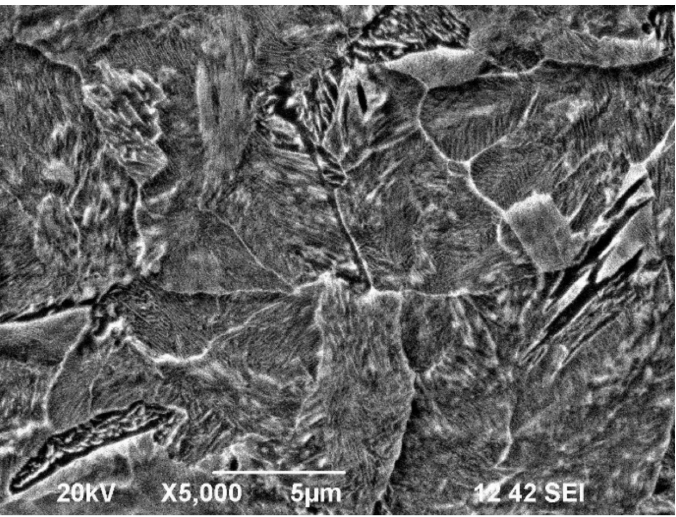
Figure 7. Microstructure of steel rod 0.70% C for metal cord manufacturing before